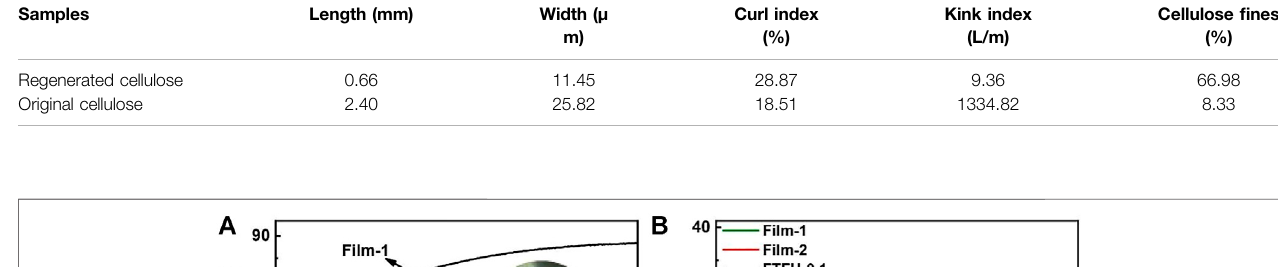
Frontiers in Energy Research |